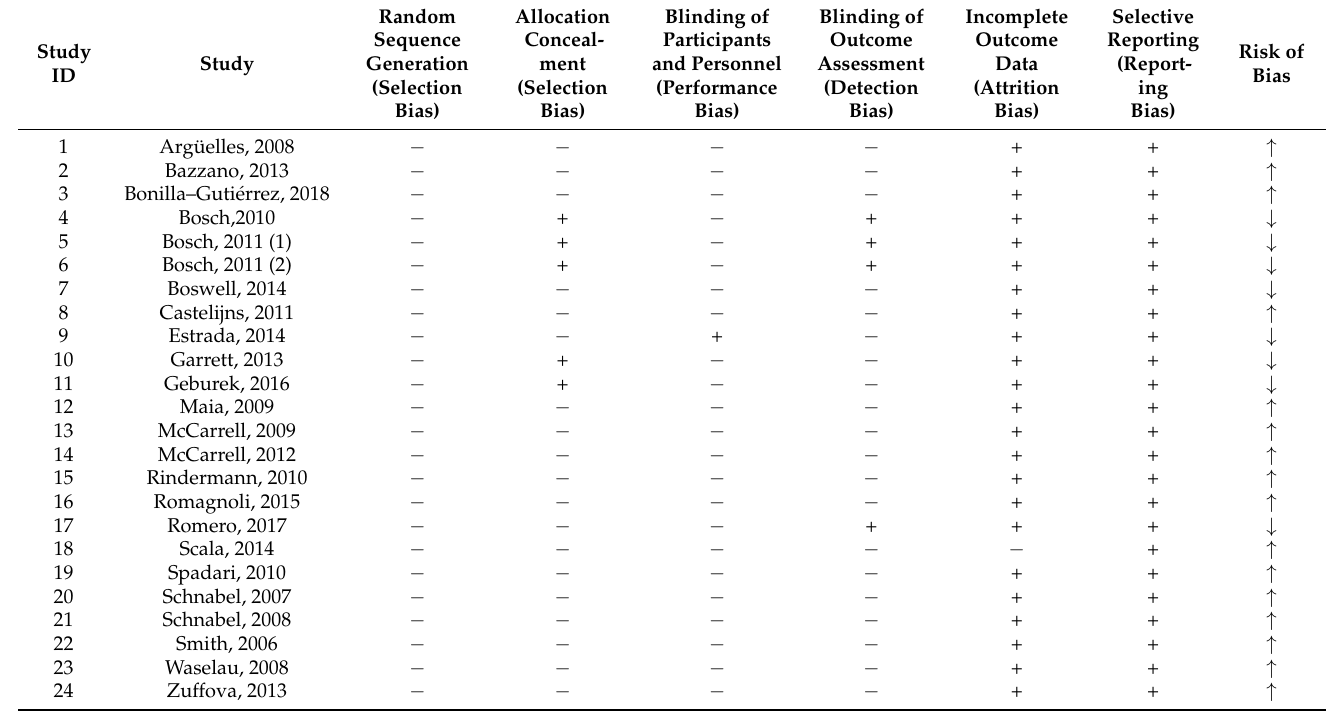
Table 1. Different sources of bias present in the studies included in the systematic